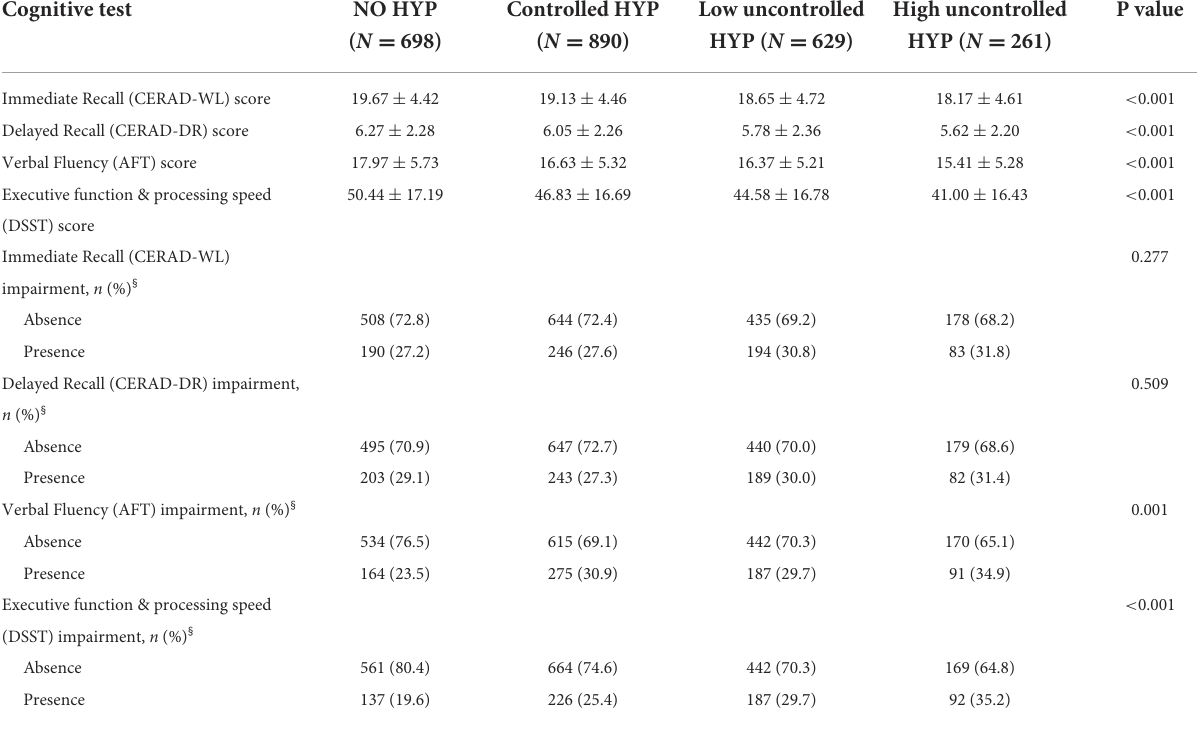
TABLE 3 The cognitive function of participants aged 60 years and older from the National Health and Nutrition Examination Survey (NHANES) (2011–2014). Cognitive